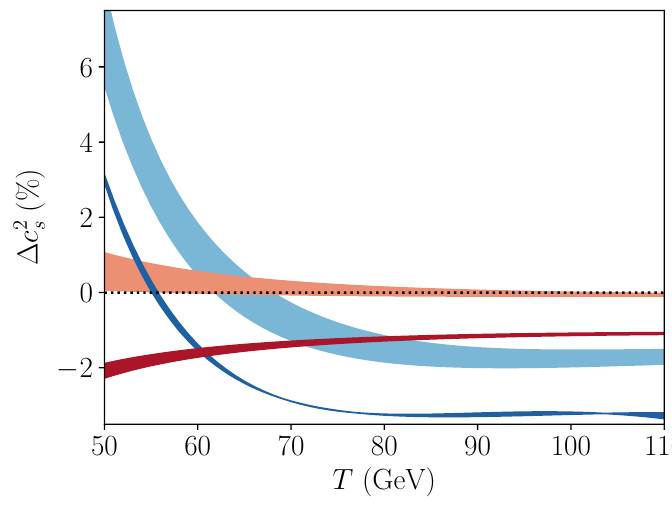
Figure 3 . Percentual deviation in the speed of sound from c 2 Higgs phase (blue) as a function of the temperature. The horizontal line indicates the value of a relativistic gas of particles. Colour codes are the same as in figure